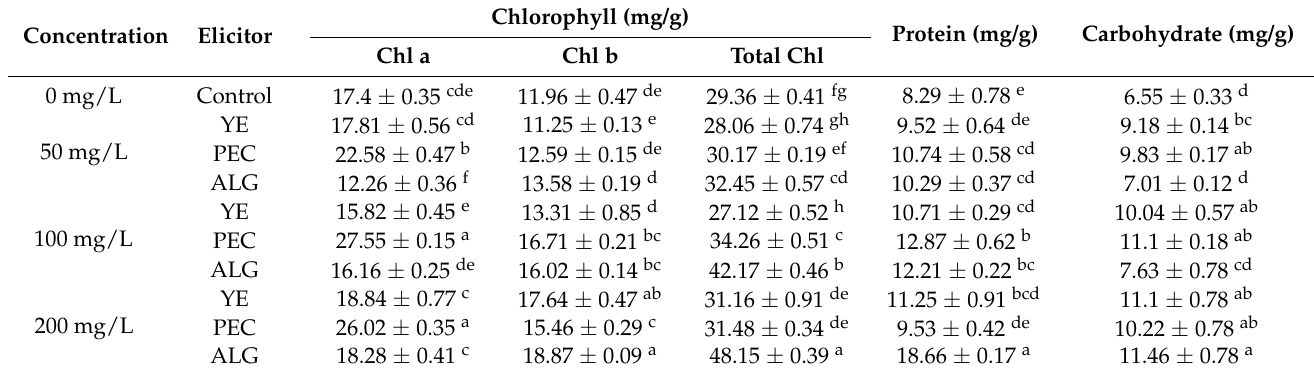
Table 1. Effect of elicitor treatments on chlorophyll, protein, and carbohydrate content in P. tuberosa shoots. Note: Values are mean ± SD, means in a column followed by different letters are significantly different from each other at p < 0.05. Mean values followed by the same letter(s) in a column are not significantly different ( p < 0.05) based on